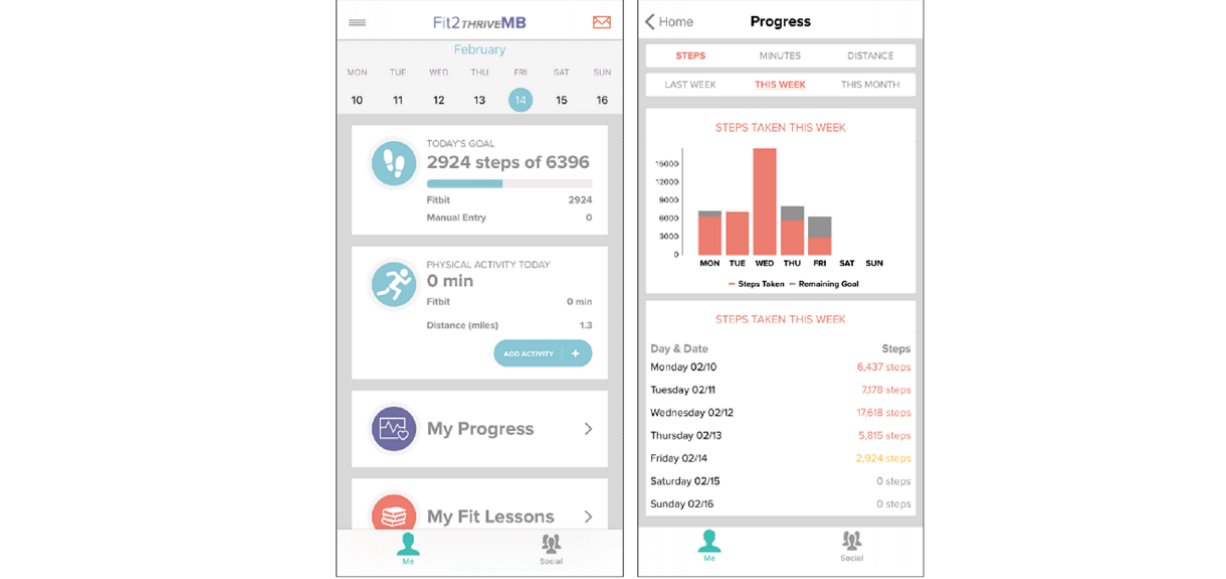
Figure 3. Fit2ThriveMB app home screen and fit progress.